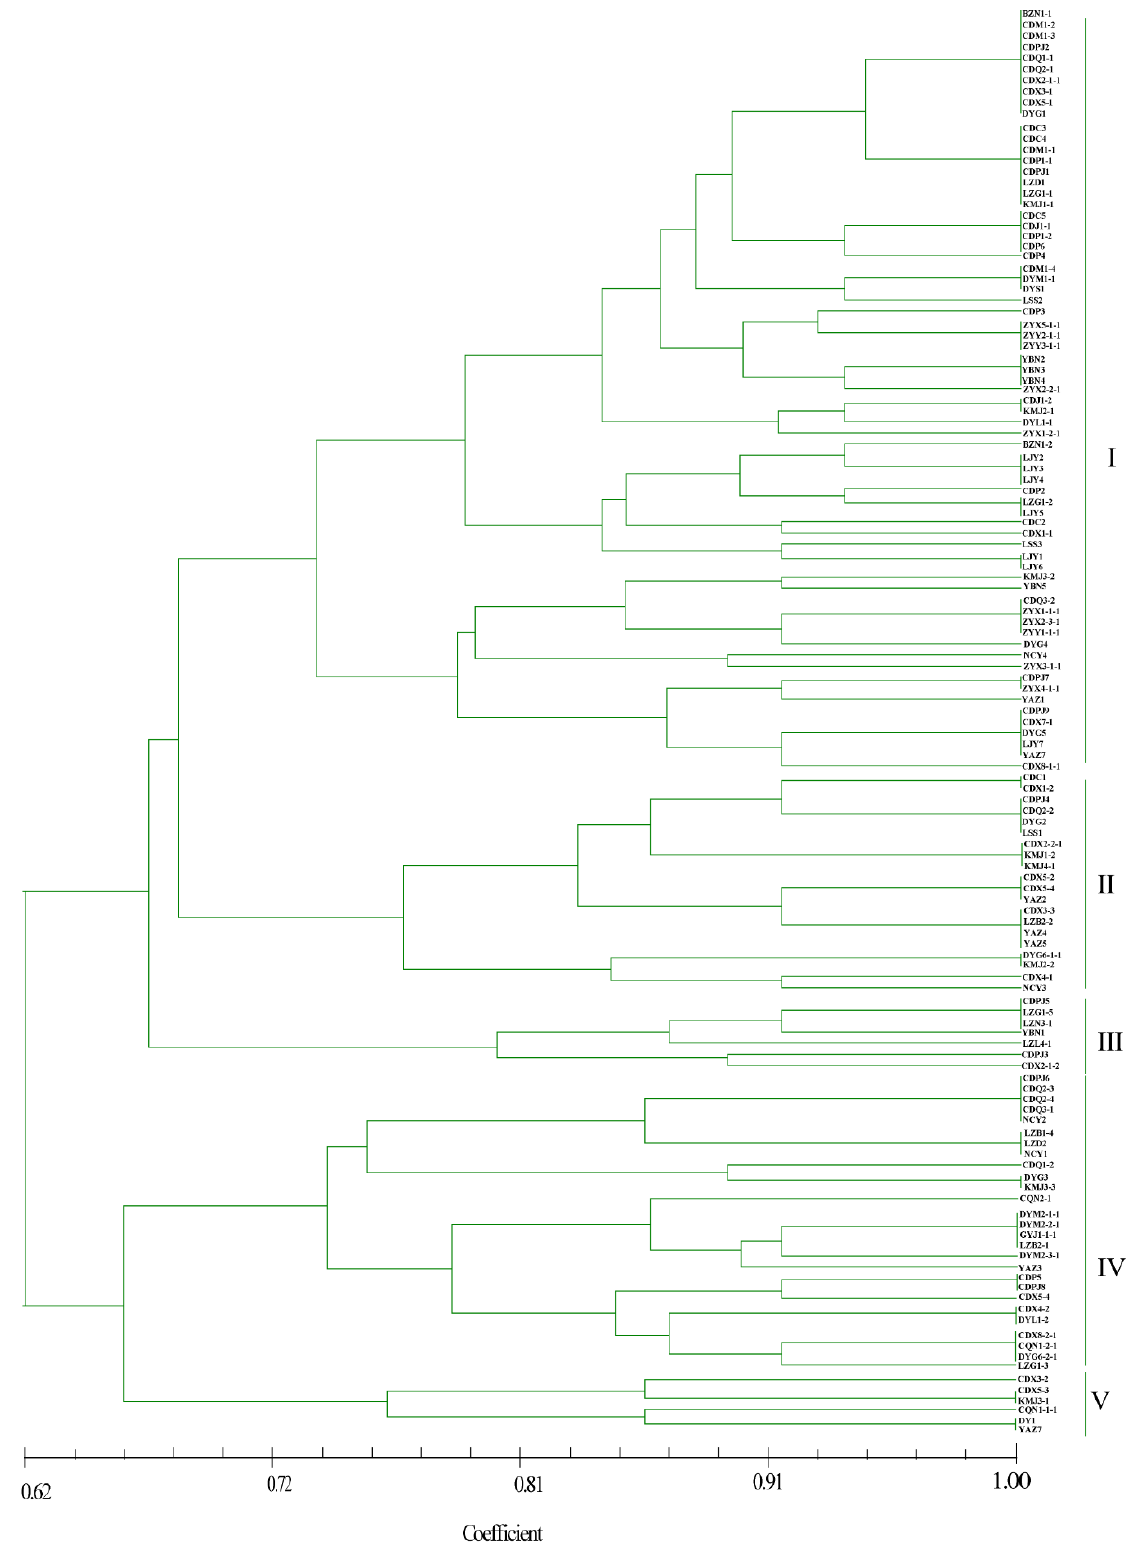
Figure 4. Dendrogram constructed with the unweighted pair-group method with arithmetic means (UPGMA) clustering method for isolates of Ustilaginoidea virens based on nine SSR primers. Five groups were divided at 0.72 genetic distance level, and most isolates were in groups I and IV.